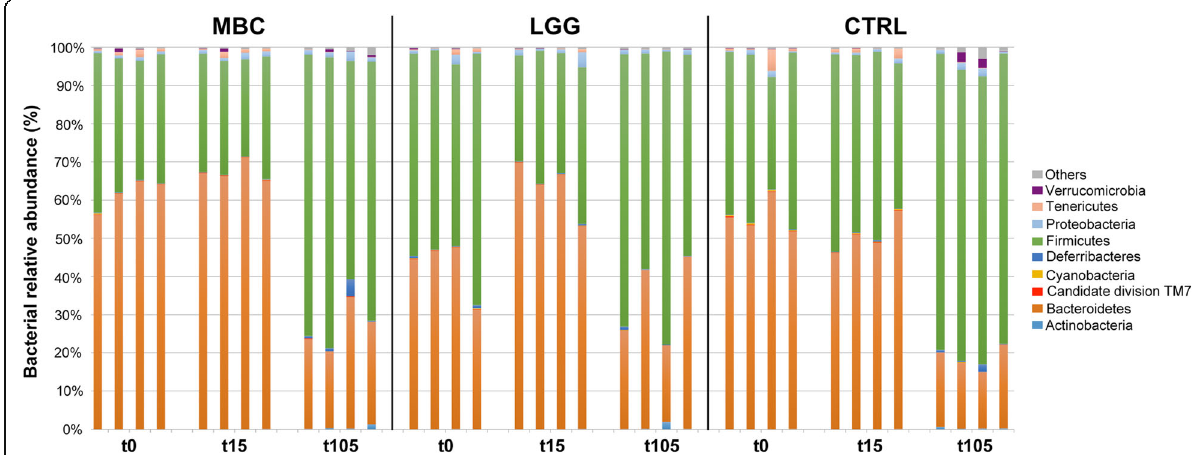
Fig. 5 Relative abundance of gut bacterial phyla obtained by NGS of faecal samples. Each bar refers to a single faecal sample and depicts the proportion of OTUs per sample, expressed as percentage. Colour coding of bacterial phyla is shown on the right side. “ Others ” includes